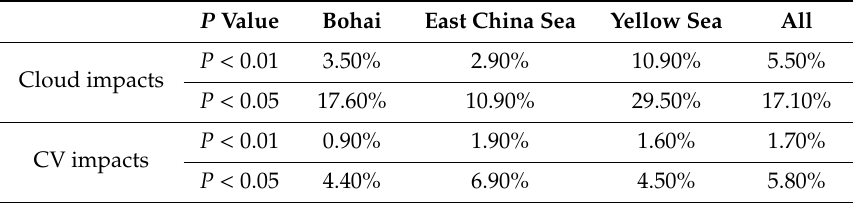
Table 3. Area percentage statistics: P values for each subregion at the monthly scale. P Value Bohai East China Sea Yellow Sea